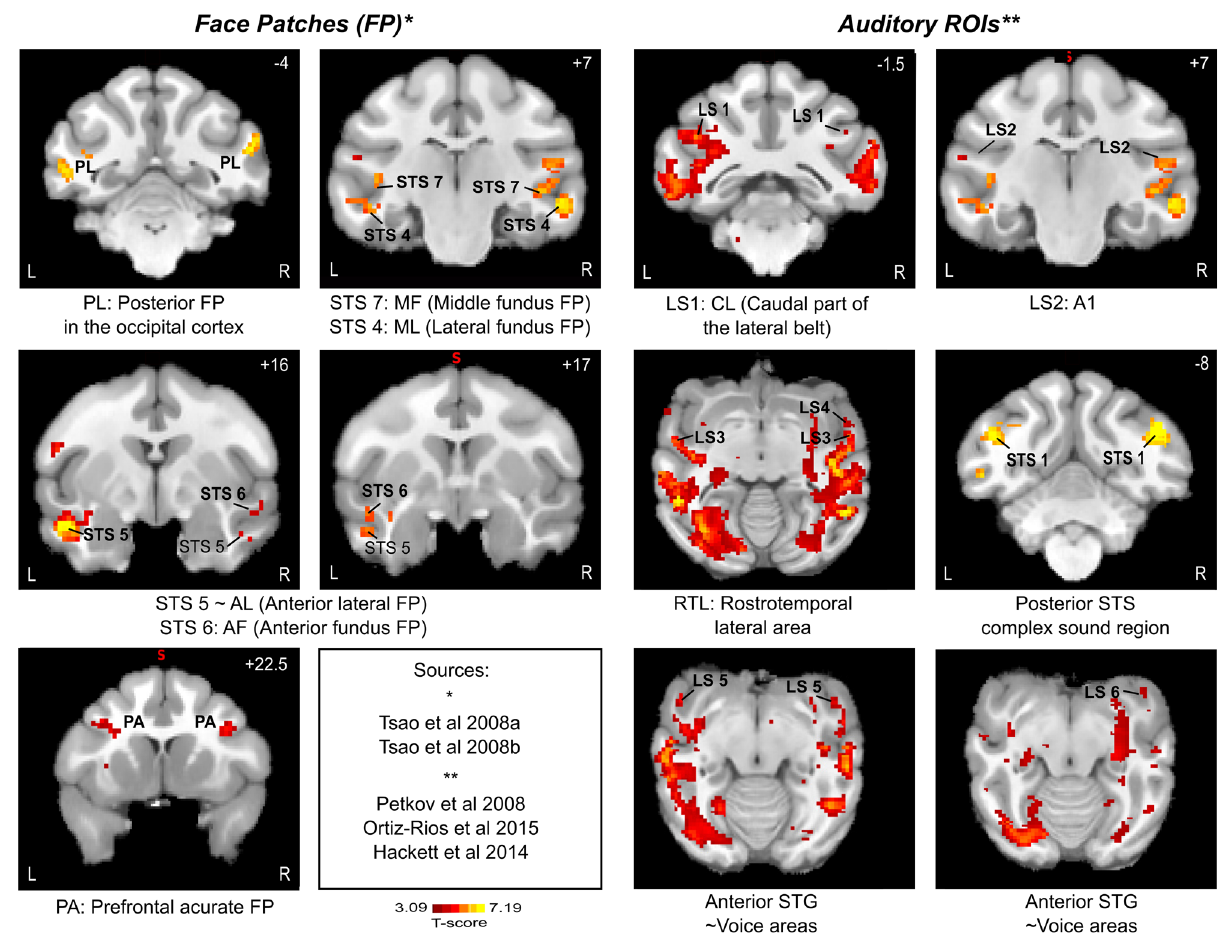
Fig. 10 | Correspondence between task-related ROIs and face patches (left panels) and voice areas (right panels). Color-scale runs start at p <0.001 uncor- rectedlevels.TaskrelatedROIsarenumberedasinFig.7.PAprefrontalacurate,AM anterior medial, AF anterior fundus, AL anterior lateral, MF middle fundus, ML